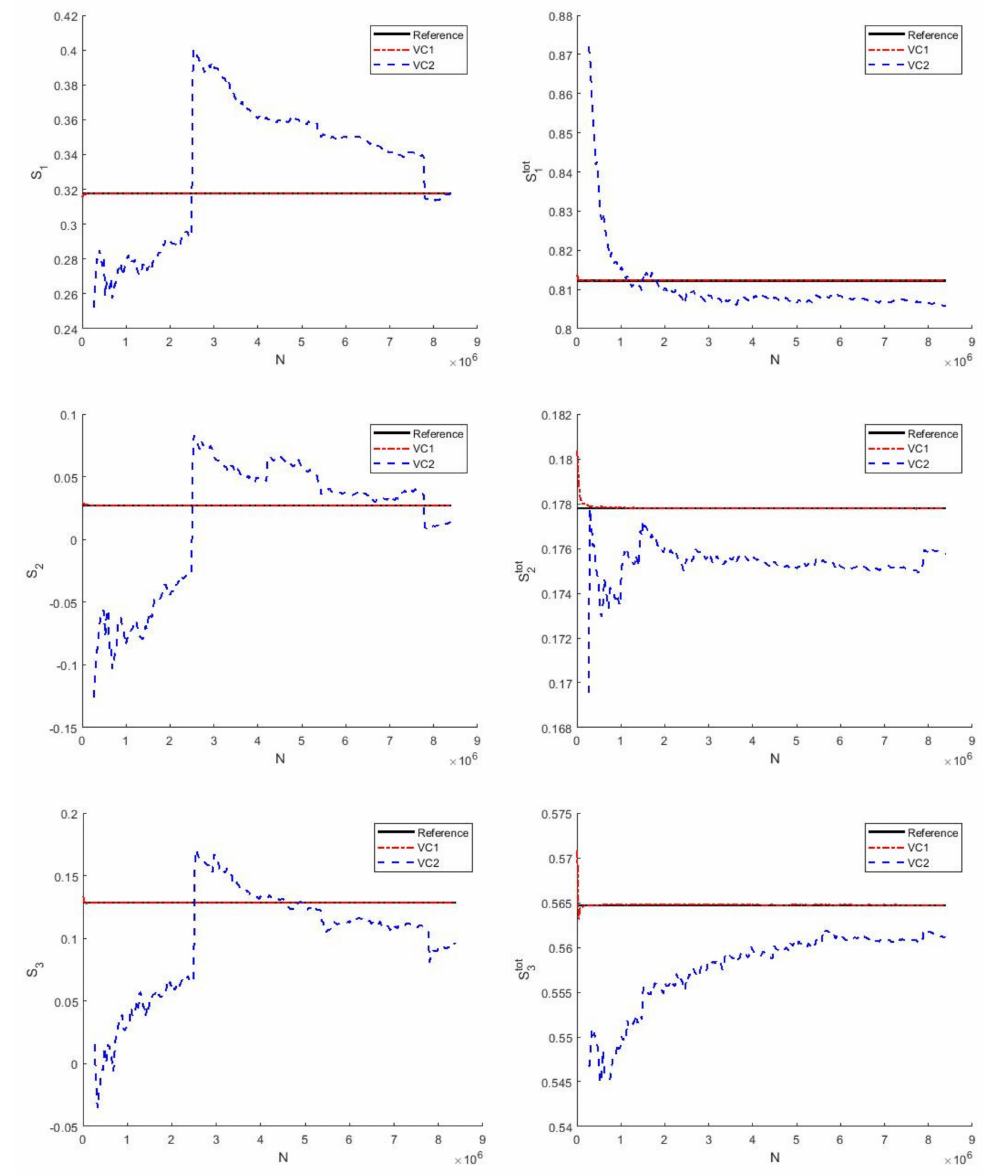
Figure 4. Convergence plots of the methods for S i and S tot